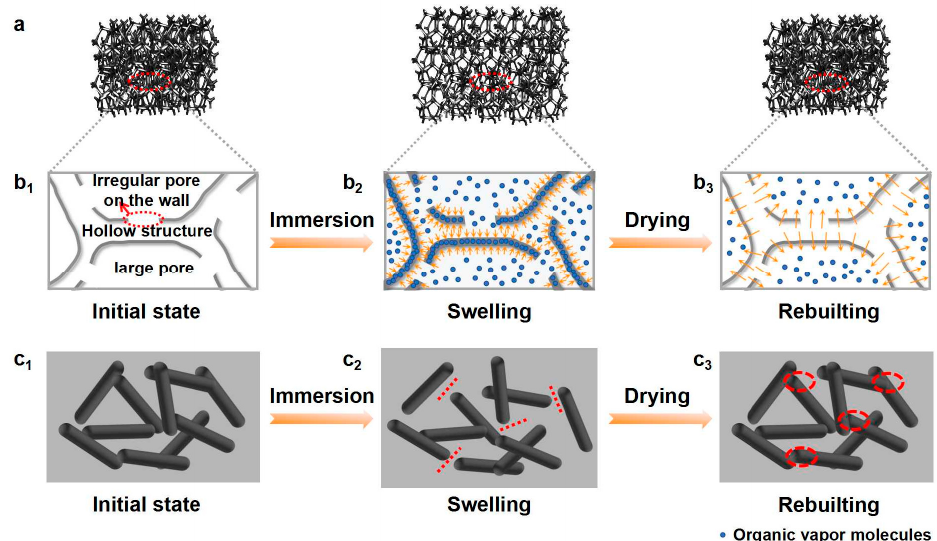
Figure 6. Figure 6. ( a ) Schematic diagram of vapor-penetration- and diffusion-induced swelling behavior of silicone rubber. ( b 1 – b 3 ) The process of organic vapor molecules’ penetration and diffusion via multilevel pore structure of CPS, and ( c 1 – c 3 ) schematic diagram of conductive network evolution with swelling of SR and then recovery. The red lines and circles depict changes in conductive